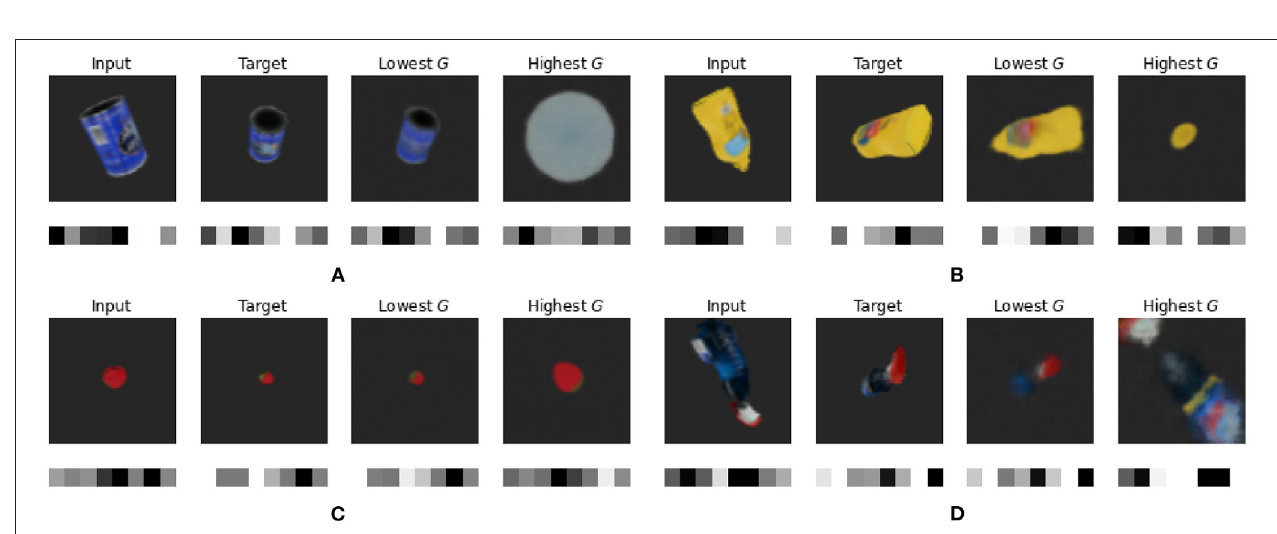
FIGURE 6 | Classification accuracy over time for an embodied agent, driven through the active inference paradigm. The agent is provided with different objects in random poses to classify, accuracy over a duration 10 steps is plotted. For each object category, 5 splits of 20 observations are classified and are used to visualize the 95% confidence bounds. The graph indicates classification accuracy over time for objects of the 26 known and 7 unknown objects. The red line represents the accuracy for the free energy agent, while the blue line represents the accuracy for the random agent. For the active inference agent, the distinction is made between the known and unknown objects: the dotted red line indicates the classification accuracy for objects of the 7 unknown object categories and the dashed line indicates the classification accuracy for the 26 known objects.